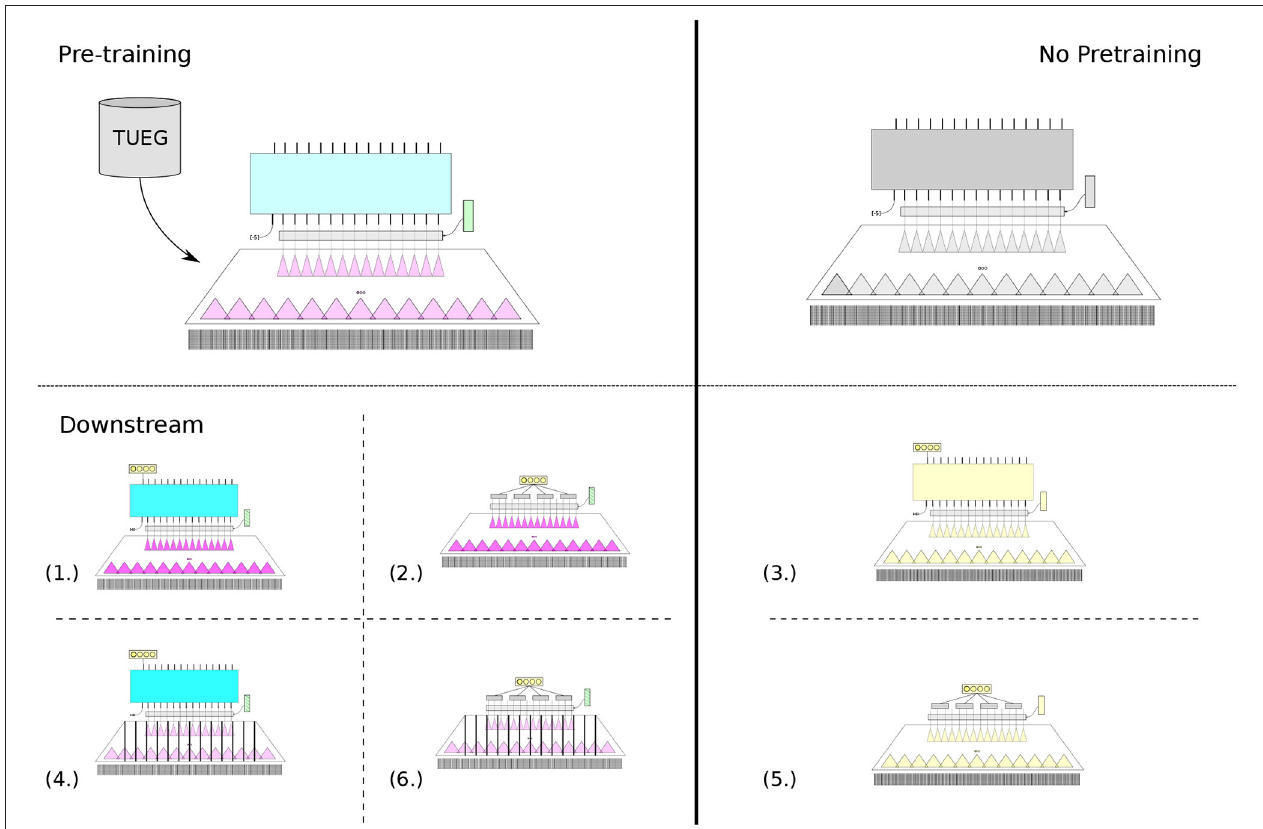
FIGURE 2 | Six different permutations of the model architecture were trained with conventional fully supervised training (in a leave-one/multi-subject-out fashion, see Table 1 ) for each downstream task. Indicated here is the portion of the overall architectures used (see Figure 1 ), and how pre-training model weights were leveraged for a four-way classification task (rectangle with four circles in it). Four tasks (left half) leveraged model weights that were first developed through pre-training. All yellow modules here indicate randomly initialized weights. Color that progresses in intensity (from pre-training to downstream) indicates further training, while added bars indicate weights that were kept unchanged during that training